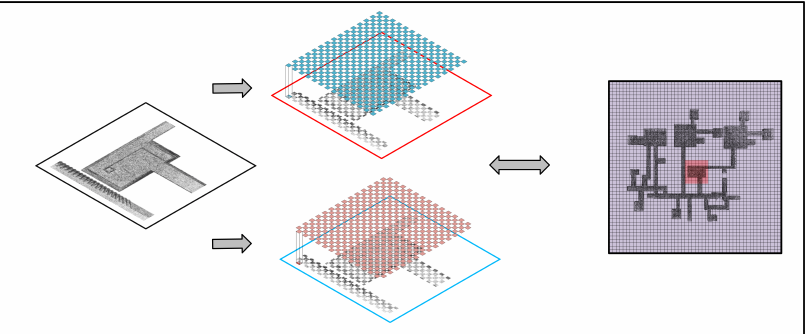
Figure 3. A schematic diagram of the holed grid structure used for the local update. The pointcloud is updated through the complementary holed grids between every two data frames and merged into the global